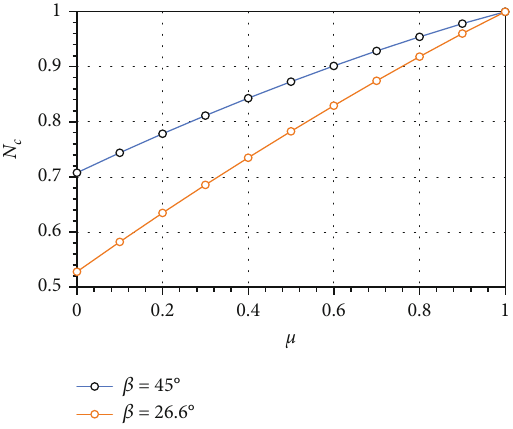
Figure 15: Variation in the bearing coe ffi cient of the ring foundation with di ff erent friction coe ffi cients.